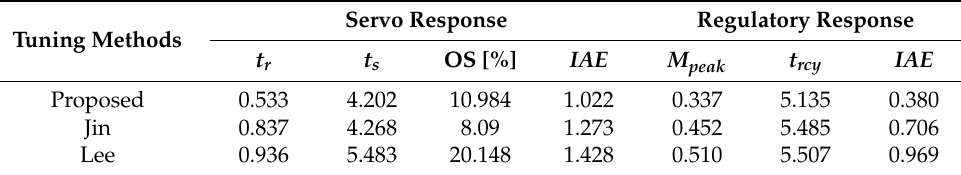
Figure 5. Unit step responses for 20% uncertainty process 𝑃 1 . Table 3. Performance comparisons for 20% uncertainty process 𝑃 1 .